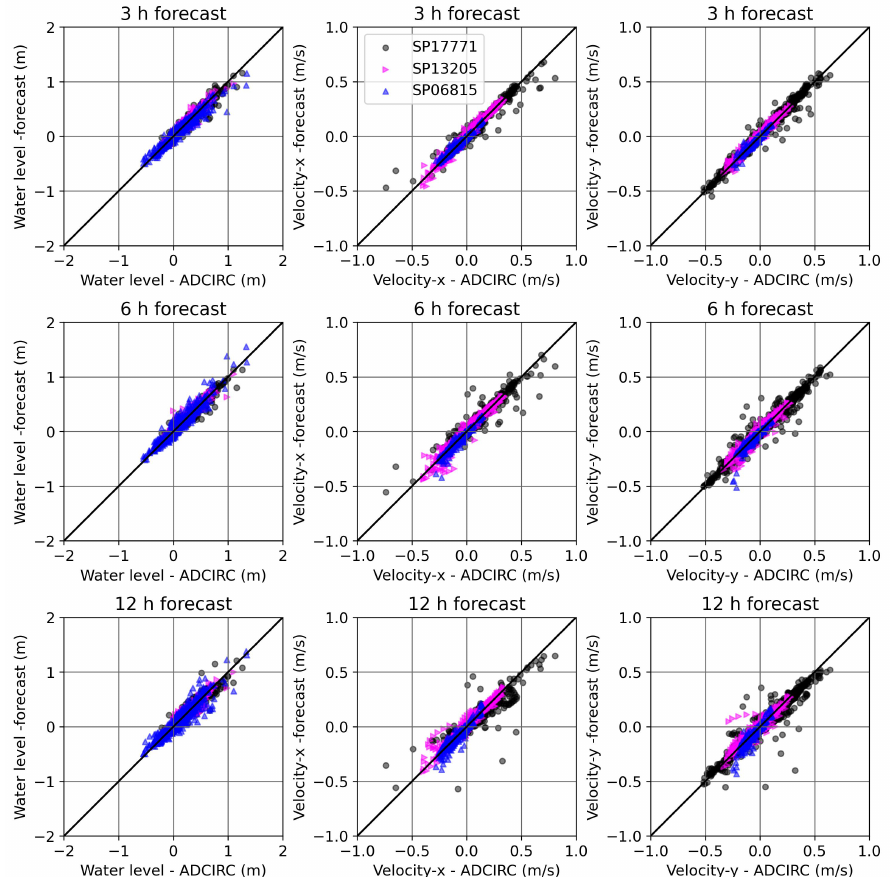
Figure 8. Scatter plot comparison of storm surge water level (left column), velocity in the x-direction (middle column), and velocity in the y-direction (right column) between neural network storm surge forecast model and ADCIRC simulation at three save points using three different forecast lead times (i.e., 3 h, 6 h, and 12 h) from top to bottom rows. SP17771: dots; SP13205: right arrows; and SP06815: upper arrows.